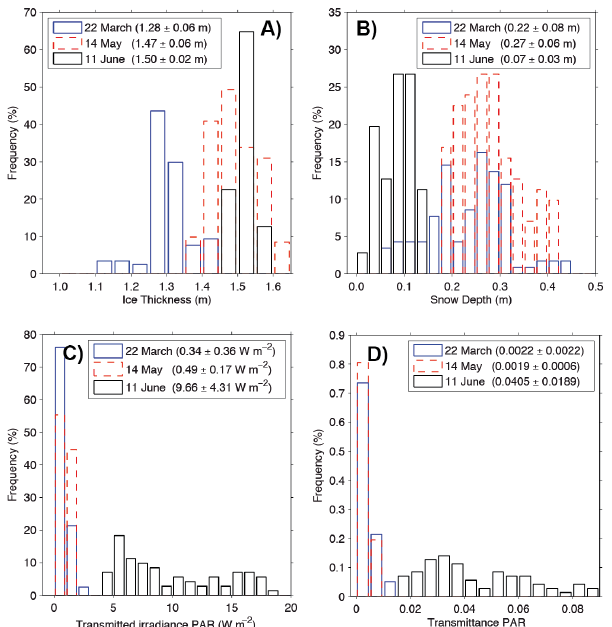
Fig. 4. Frequency distributions of (a) sea-ice thickness and (b) snow depth (c) transmitted irradiance of PAR, and (d) transmittance of PAR along the transects. Mean values of all distributions are given as mean ± one standard deviation in the legends.